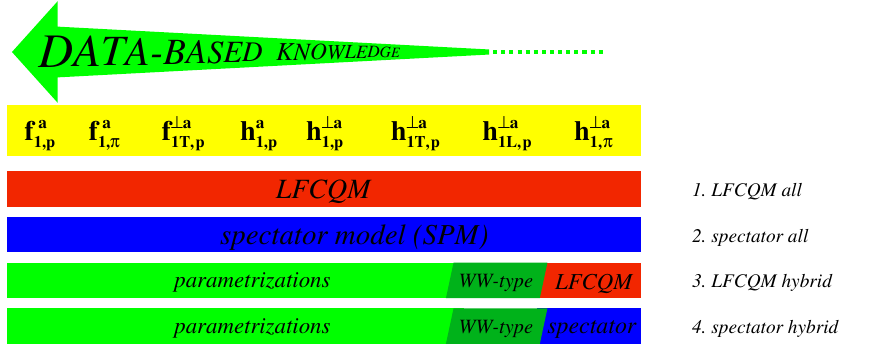
Figure 2 . TMDs entering the pion-induced polarized DY process at leading twist in the order from the phenomenologically best to least known, and the approaches used in this work, see